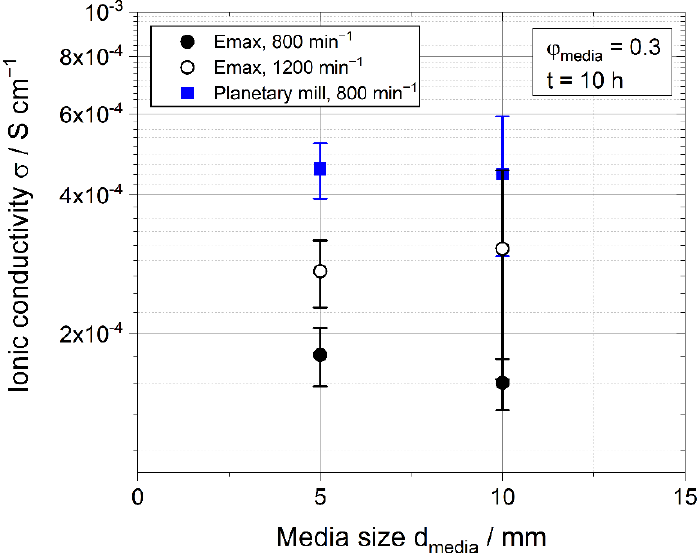
Figure 12. Ionic conductivity of Li 6 PS 5 Br after 10 h of mechanochemical treatment in an Emax ( n = 800 min − 1 and n = 1200 min − 1 ) and planetary ball mill ( n = 800 min − 1 ), φ (cid:2923)(cid:2915)(cid:2914)(cid:2919)(cid:2911) = 0.3.